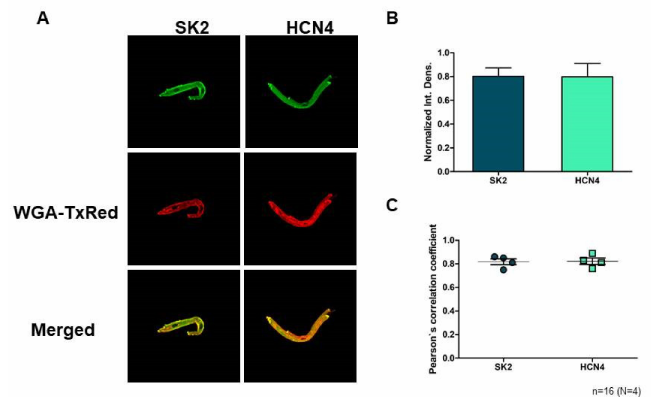
Figure 1. ( A ) shows representative immunofluorescent images of rabbit sinus node cells with SK2 and HCN4 immunolabelling. ( B ) shows the relative expression of SK2 and HCN4. There were no significant changes between the SK2 and HCN4 fluorescence intensity. ( C ) shows fluorescence colocalization analysis. One data point represents one animal. Four cells were evaluated and averaged from each animal. Data are presented as mean ± SEM, applied statistical probe was unpaired Student’s t -test ( p ≤